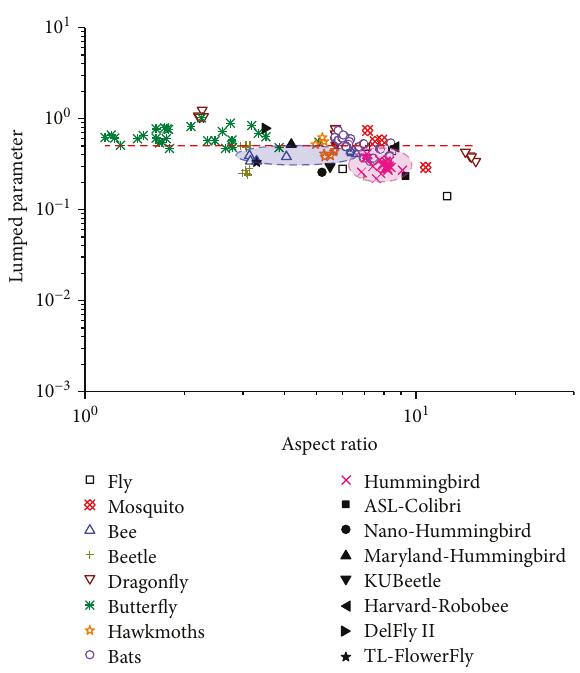
Figure 10: Relation lumped parameter vs. aspect ratio including the fl apping wing